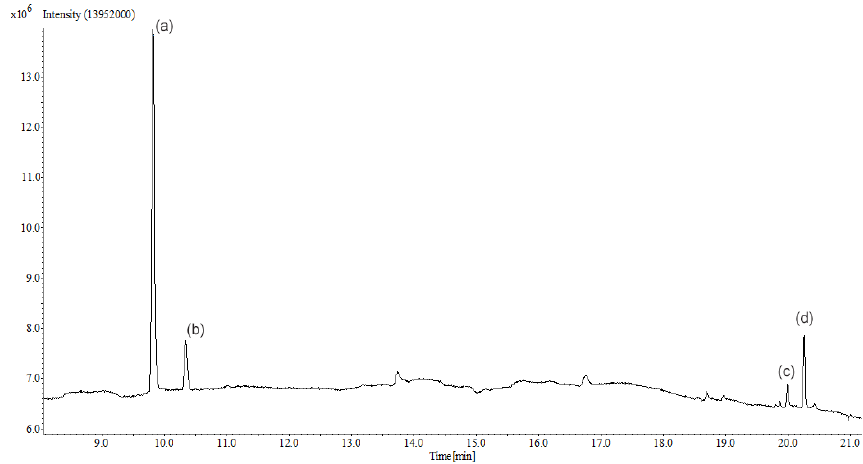
Figure 3. SPME/GC-TOFMS chromatogram for the reaction of 4MCHexOH with Cl atoms after 15min of reaction. Peak (a) is 4MCHexOH, peak (b) is (E)-4-methylcyclohexanone, and peaks (c) and (d) are reaction products.